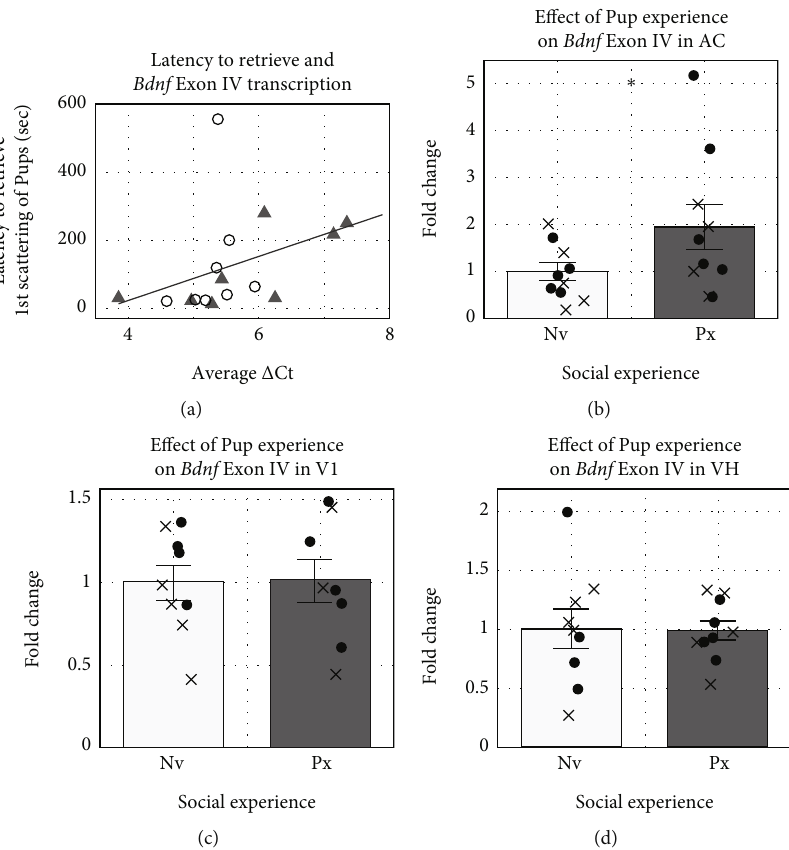
Figure 4: Pup experience while hearing pup calls increased Bdnf exon IV transcription speci fi cally in AC. (a) In AC, more Bdnf exon IV transcripts was signi fi cantly associated with shorter latency to retrieve pups in the fi rst scattering trial. Data from runs 1 (triangles) and 2 (open circles) combined. (b) Pup experience signi fi cantly increased Bdnf exon IV transcription in AC. Data from Bk ( fi lled circles) and E2 (x) pooled for both Nv and Px subjects. (c) In V1, the mRNA from Bdnf exon IV demonstrated no signi fi cant di ff erence between conditions. (d) In VH, the mRNA from Bdnf exon IV demonstrated no signi fi cant di ff erence between conditions. ∗ indicates p value <